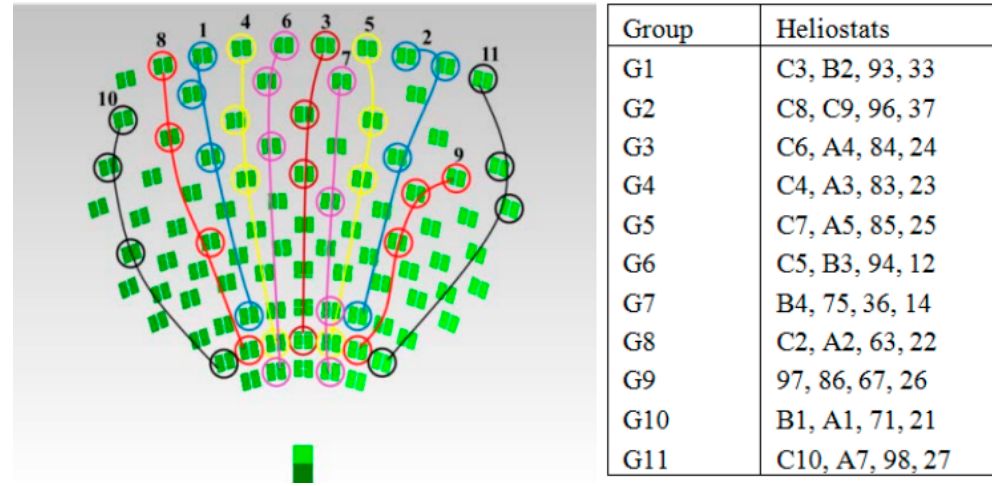
Figure 6. Groups of heliostats in which the field has been divided.